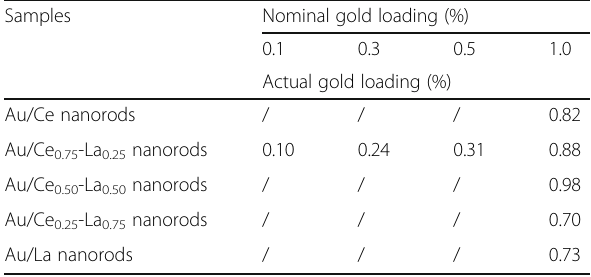
Table 2 BET specific surface area of the Ce-La nanorod